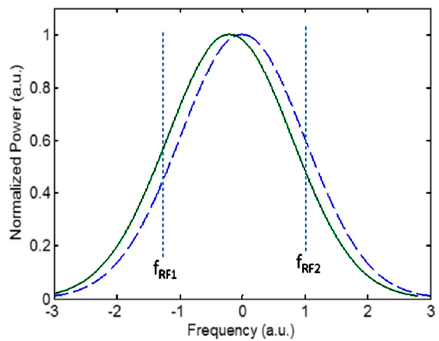
Figure 2. Principle of monitoring the radio frequency (RF) power at selected frequencies as the MWP filter response | H ( f RF ) | shifts.